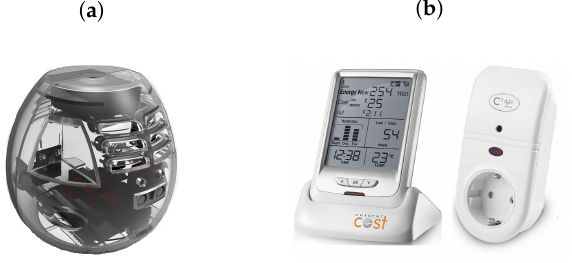
Figure 1. Sensor Modules: ( a ) Sensor Box; and ( b ) Electricity Monitor.